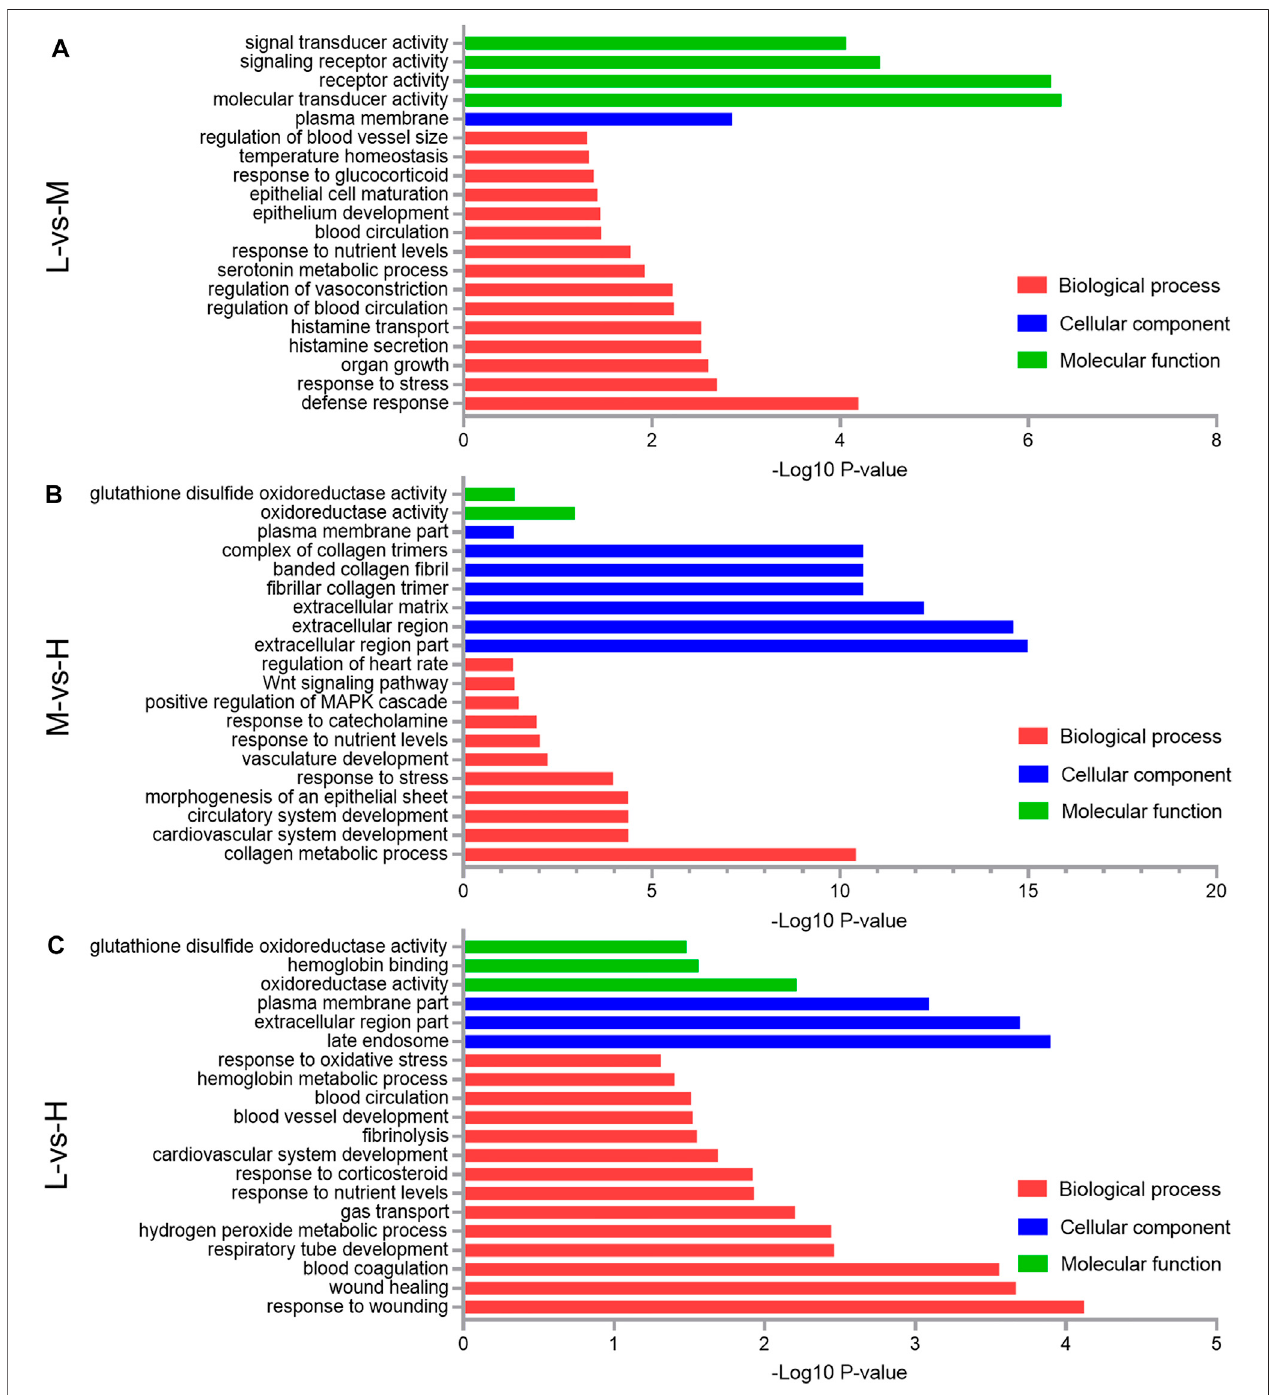
FIGURE 6 | Gene Ontology (GO) classi fi cation of the differentially expressed genes (DEGs) comparing the L and M (A) , M and H (B) , and L and H (C) . A portion of the signi fi cantly enriched biological process, cellular component, and molecular function GO terms is shown.